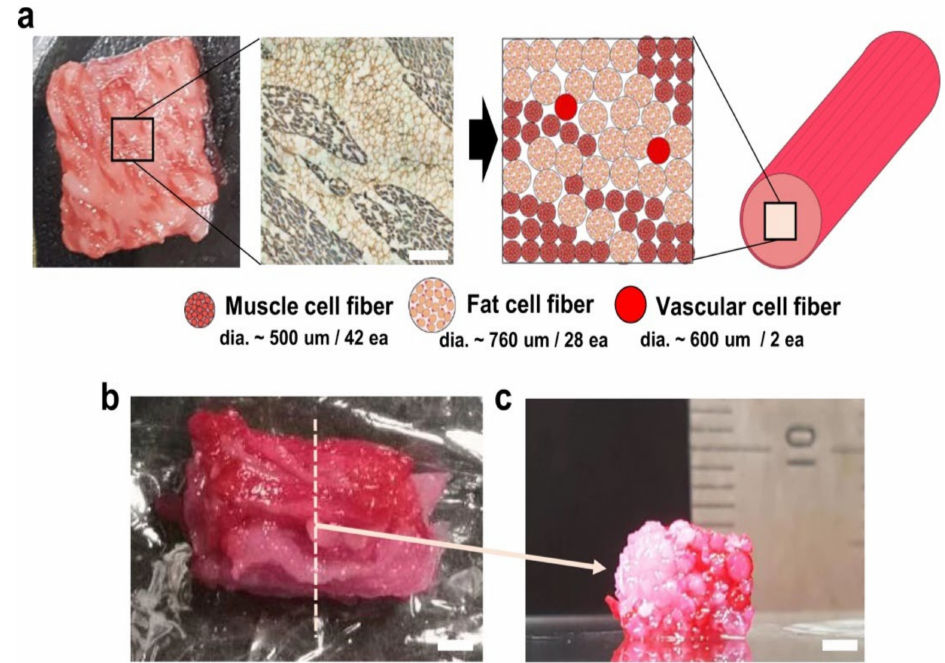
Figure 3. Assembly of fibrous muscle, fat, and vascular tissues to cultured steak. ( a ) Assembly schematic—(right) based sarcomeric α -actinin (blue) and laminin—(brown) stained image (left) of the commercial meat. It is assumed that the diameters of the fibrous muscle, fat, and vascular tissues are about 500, 760, and 600 µ m, respectively. Scale bar, 1mm. ( b , c ) Optical images of the cultured steak by assembling muscle, fat and vascular tissues at ( b ) the top and ( c ) cross-section view of the dotted-line area. Muscle and vascular tissue were stained with carmine (red color), but fat tissue was not. Scale bars, 2mm.—Reproduced with permission from